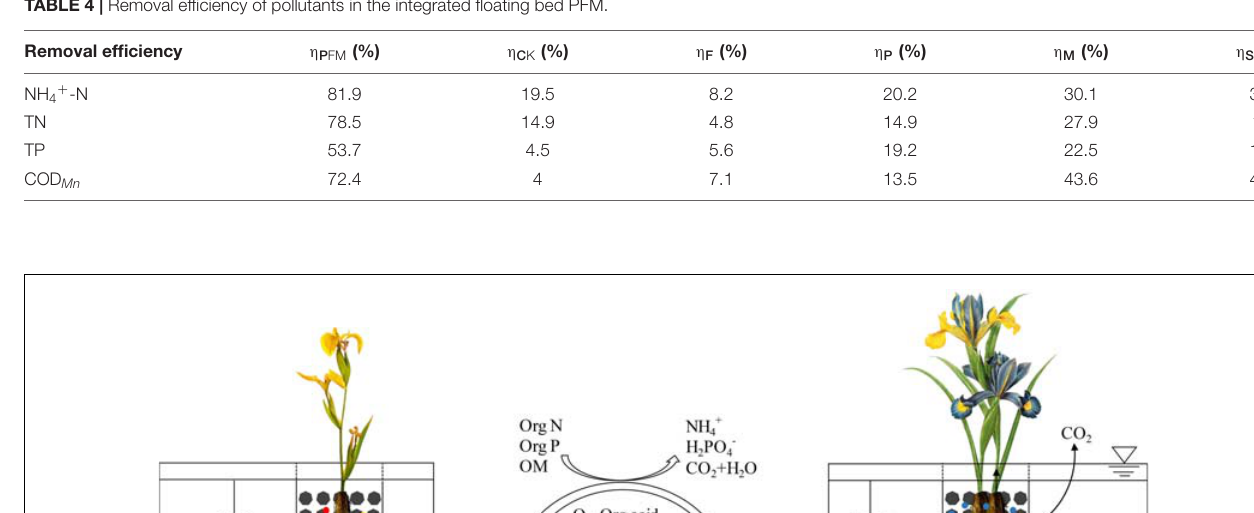
TABLE 4 | Removal efficiency of pollutants in the integrated floating bed PFM.